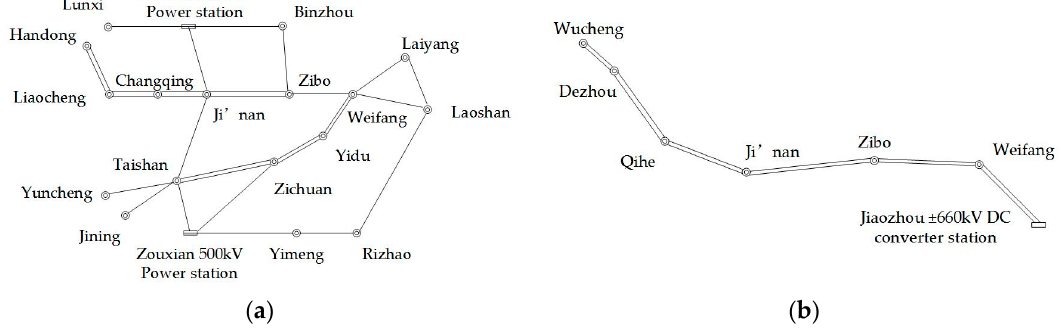
Figure 4. Diagram of Shandong transmission line. ( a ) 500 kV. ( b ) ±660 kV.